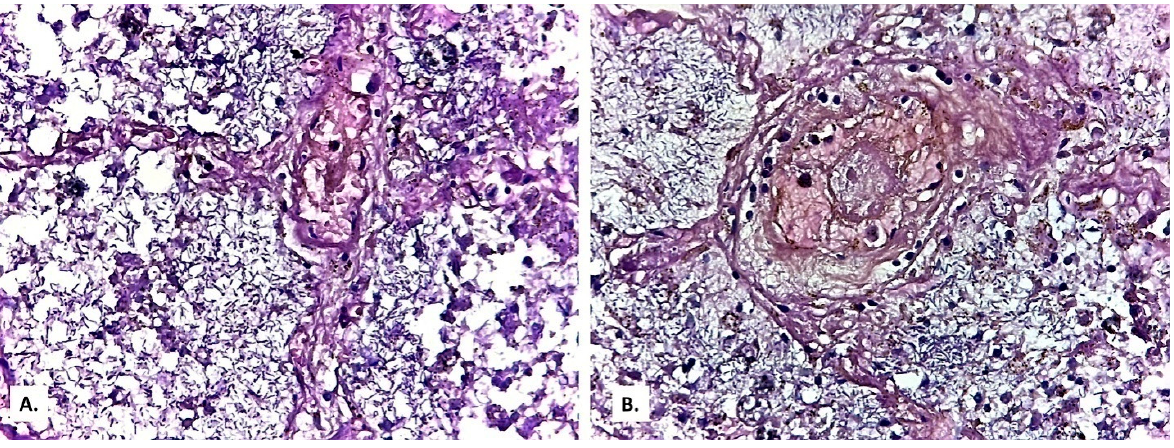
Figure 11. Filamentous bacterial invasion (Giemsa × 400) (( A ) microscopic field 1; ( B ) microscopic field 2) .